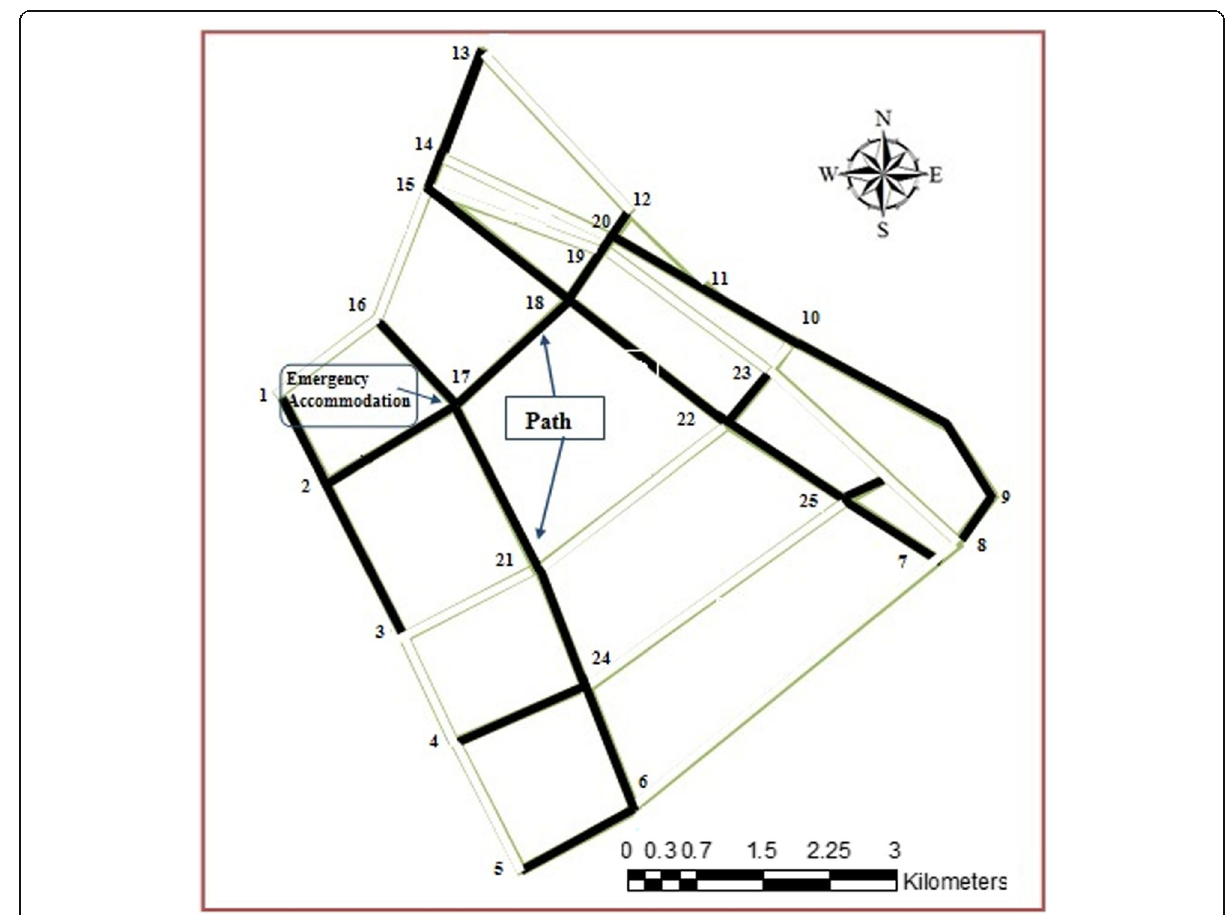
Fig. 17 Optimal road network for emergency evacuation in district 7, Shiraz by integrating all